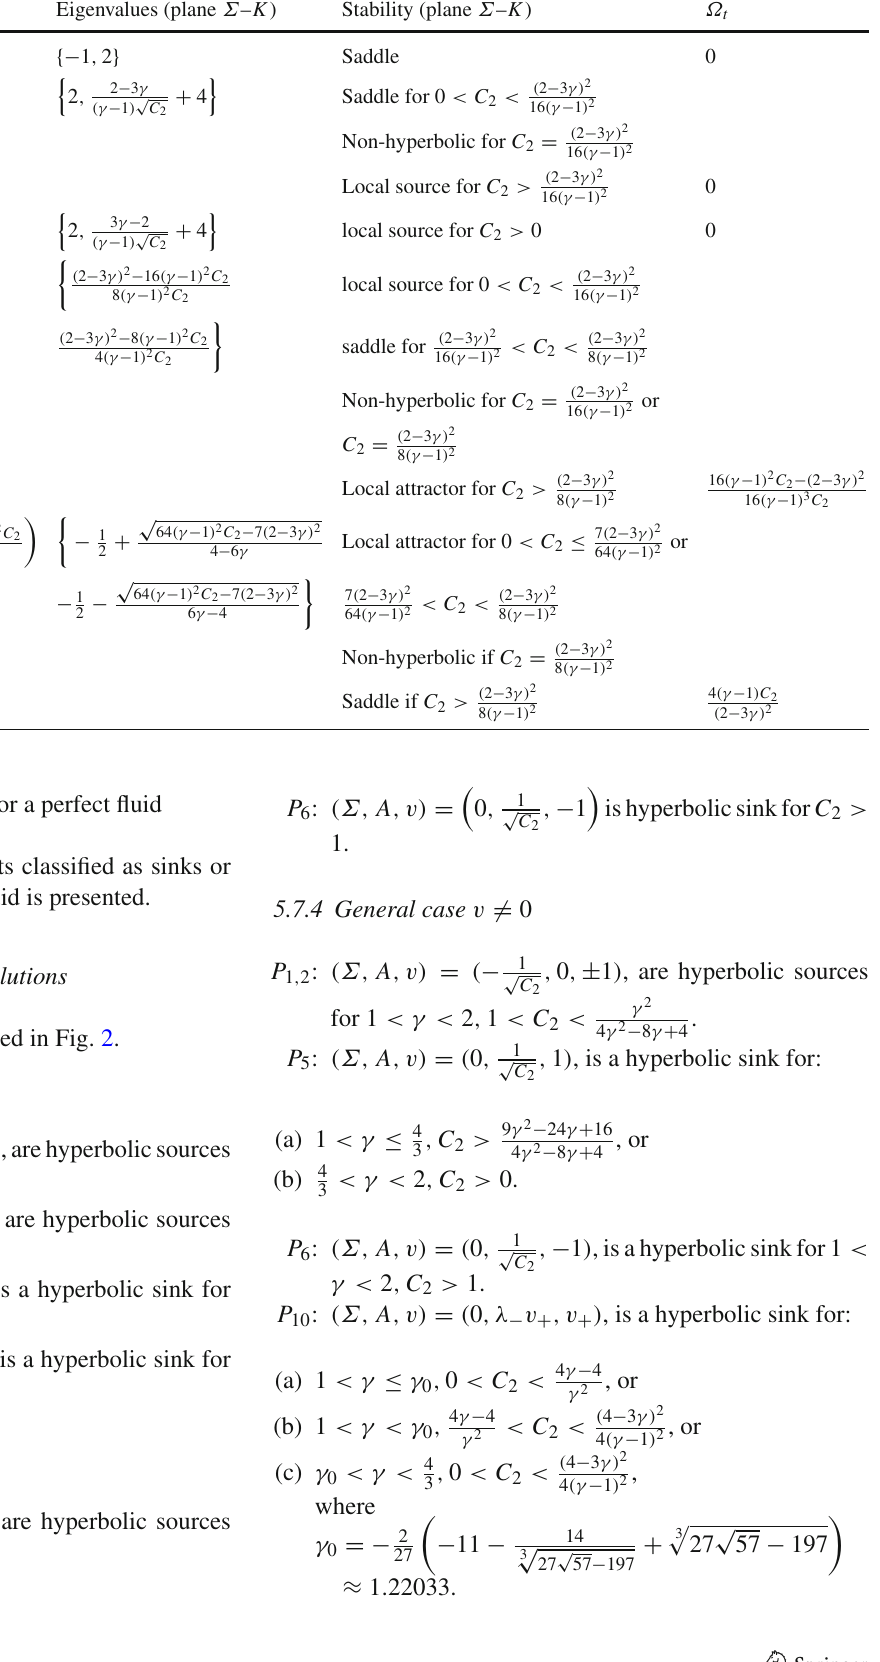
Table 3 Qualitative analysis of the equilibrium points of the system (77) with v = A = 0. Line N 1 is included Equil. points (Σ, K ) Eigenvalues (plane Σ – K ) Stability (plane Σ – K ) Ω